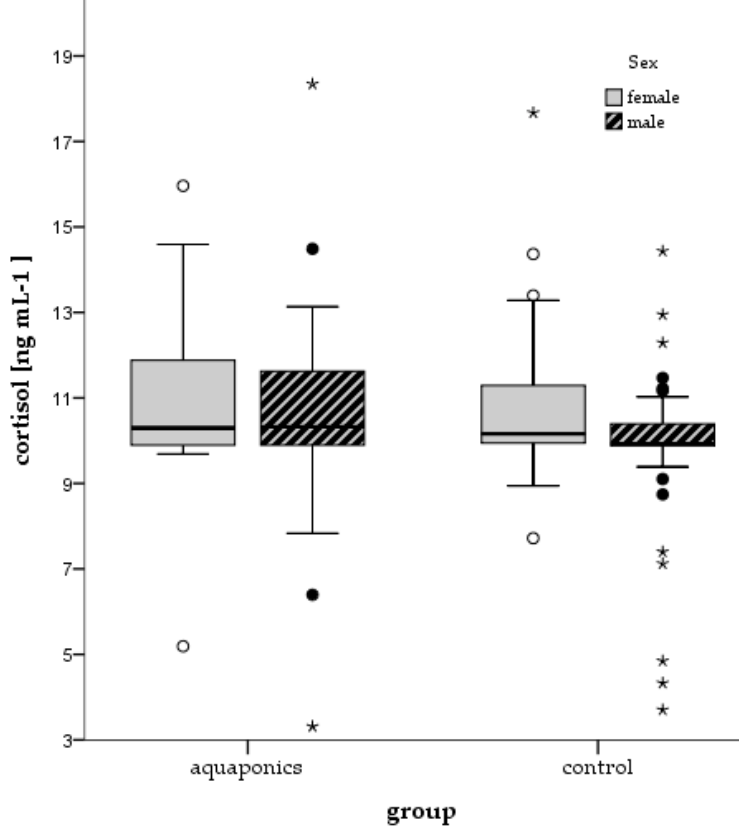
Figure 12. Cortisol levels of African catfish ( C. gariepinus ) in different cultivation groups, subdivided by genders. Illustrated is the sampling in small groups over the entire experiment. Outliers: ○ / ● ; extrem values: *.